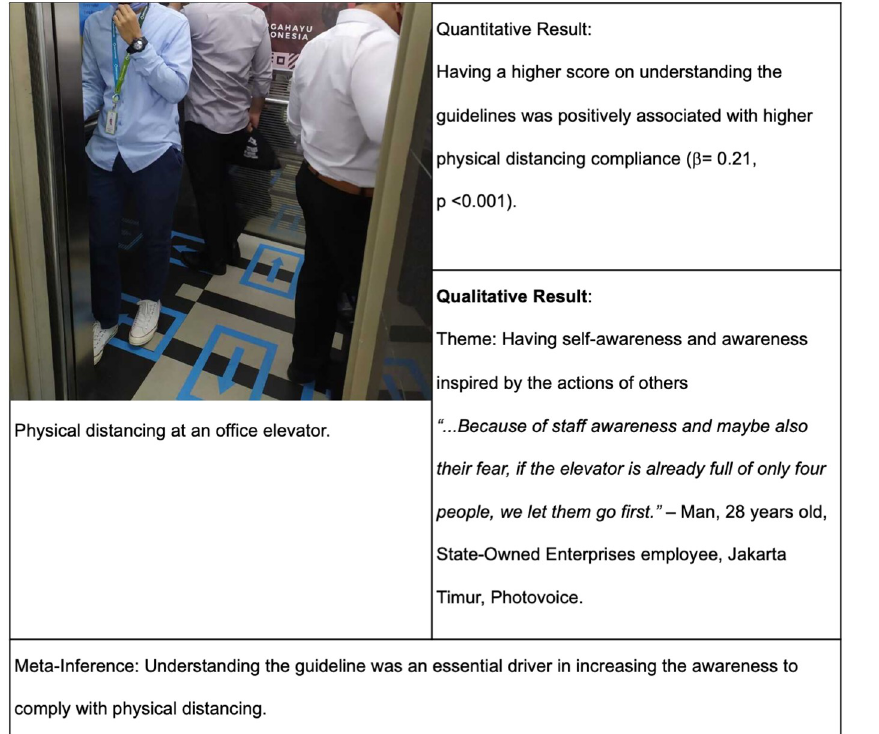
Fig 3. Joint display of understanding guideline, awareness, and physical distancing